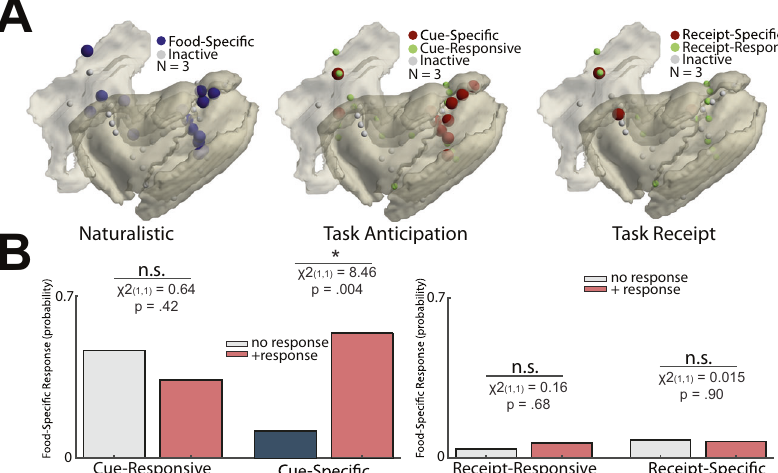
Fig. 6 Food-speci fi c responses during anticipation are maintained in task-based and natural eating settings. A Topography of response types in the insular/opercular cortex during task-based and natural eating. During eating of a standard meal, a food-speci fi c site (blue electrodes) was de fi ned as a signi fi cant difference in HFB time-locked activity between food types near the time that food was about to enter a subject ’ s mouth, whereas gray electrodes indicate a non-responsive response. During a task, a cue-speci fi c response (red electrodes) was de fi ned as a signi fi cant difference between palatable and neutral conditions for either anticipation or receipt of these solutions. Green electrodes (cue-responsive sites) denote signi fi cant HFB activity compared to pre-cue baseline activity, but no difference between palatable and taste-neutral conditions. Gray electrodes denote activity was not different from pre-cue baseline activity. Electrodes visualized are from the three subjects shown in Fig. 5. B The probability of a channel being food-speci fi c during eating with and without signi fi cant response during task anticipation. Left: Cue-responsive contacts without discriminatory activity during anticipation were not associated with food-speci fi c eating responses. However, the presence of cue-speci fi c activity was signi fi cantly associated with the presence of food-speci fi c eating responses. Right: Amongst all electrodes, neither receipt-responsive nor receipt-speci fi c responses were associated with food-speci fi c